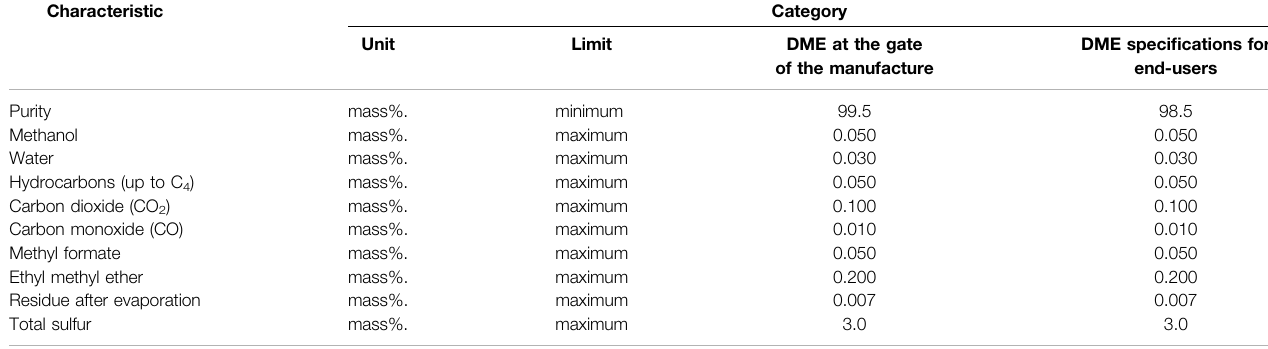
TABLE 1 | ISO 16861:2015 standard for DME as a fuel (ISO, 2020). Characteristic